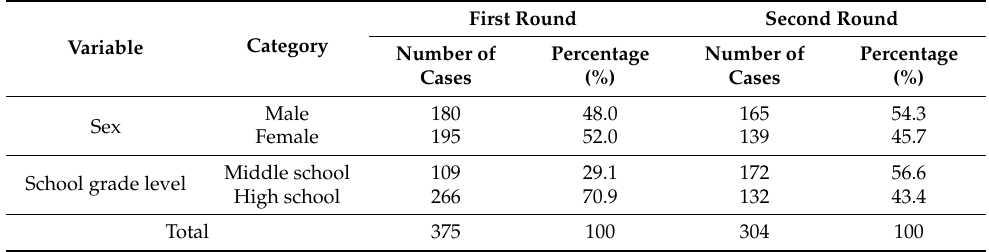
Table 1. Participants’ demographic